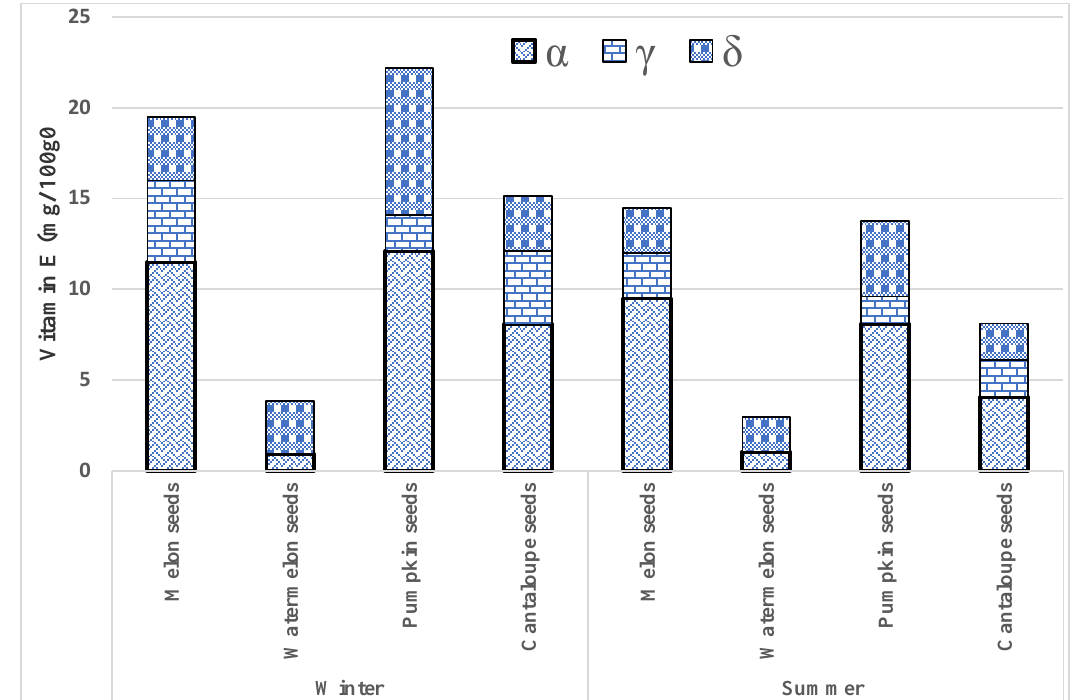
Figure 4. The variation of individual and total tocopherol in edible seed samples from winter and summer seasons.